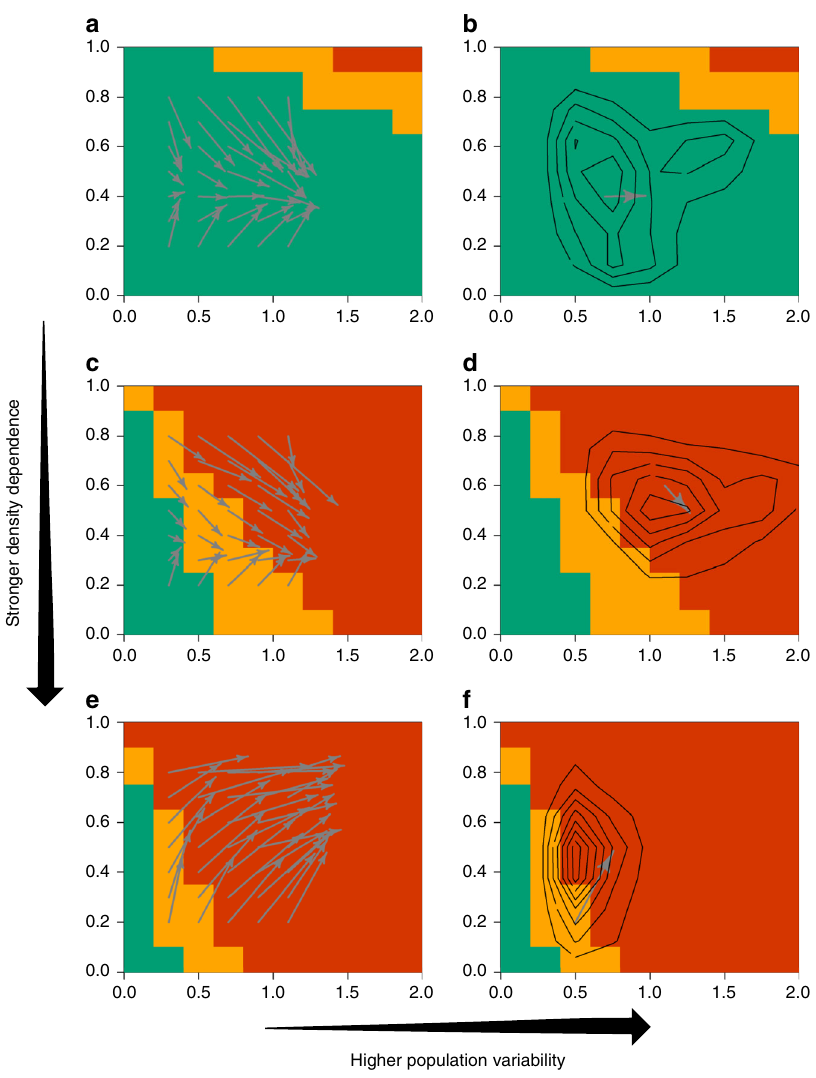
Fig. 3 Directionality and strength of bias in risk estimates. The directionality and strength of bias in risk (of large bias in population status) estimates for different combination of population variability and density dependence for a very slow-growing species, c medium-growing species, and e very fast- growing species with a time series length ranging from 21 to 30 years. The longer the arrow, the stronger the bias. In this illustration, the base of the arrow shows the point estimates based on the GSSM fi t to data and the arrow points towards the center of gravity of the “ true ” parameter range that likely generated such values based on simulation. The underlying color-coded risk map (orange-red >60%, orange between 30 – 60%, and bluish-green <30% chance of estimating the fi nal-year depletion level with at least 50% bias) is represented based on the total (both process and observation) population variability measured in terms of coef fi cient of variation and population density dependence. The plot is restricted to the parameter range used in the simulation studies. b , d , f Contour plots of the back-calculated “ true ” parameter range for a few examples of very slow-, medium-, and very fast-growing species. Contour lines represent the probability density with higher density at the center of the